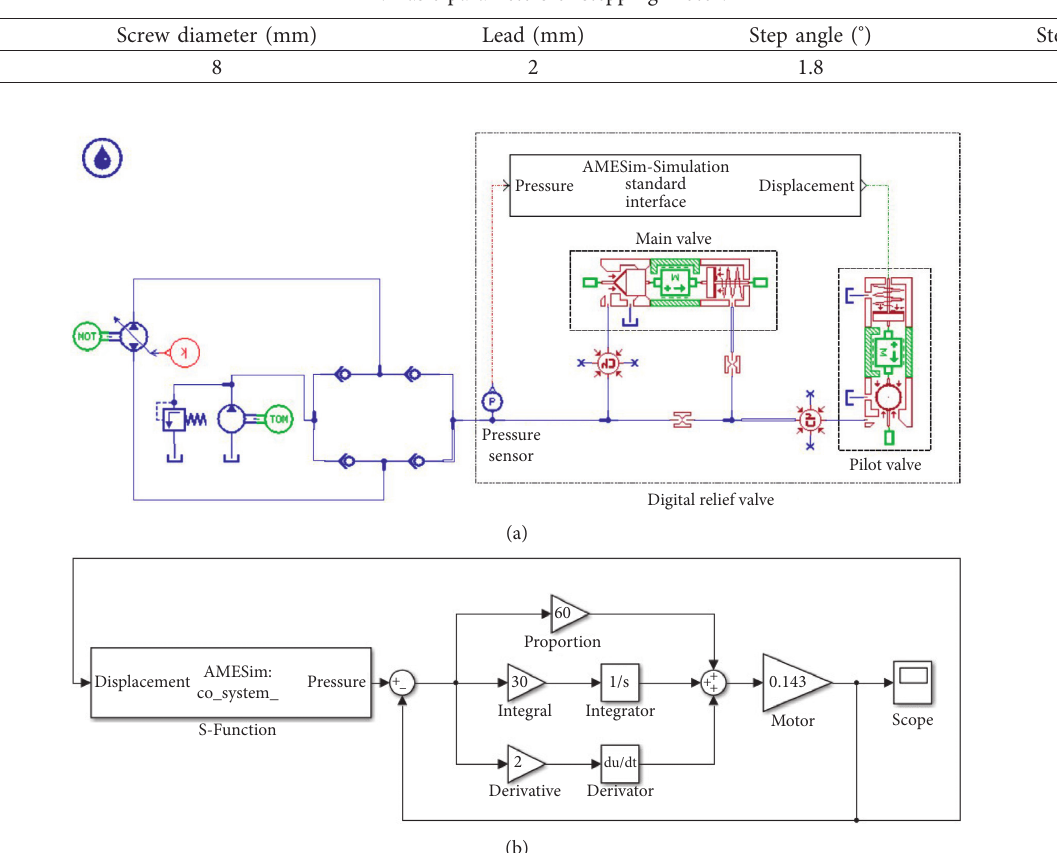
Table 1: Basic parameters of stepping motor.